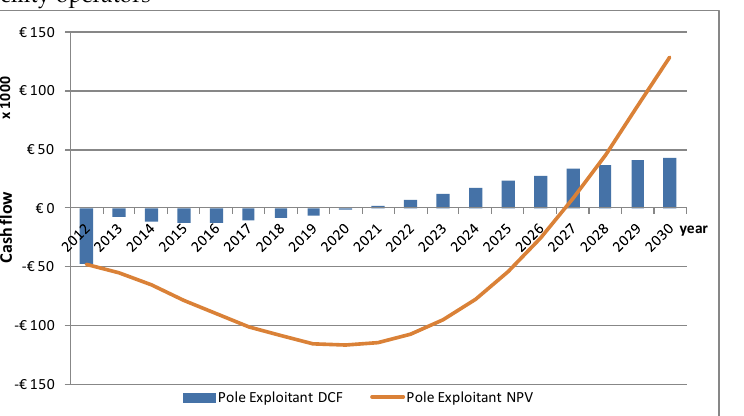
Figure 12. Evolution of the NPV for the charging pole exploitant (scen. D)